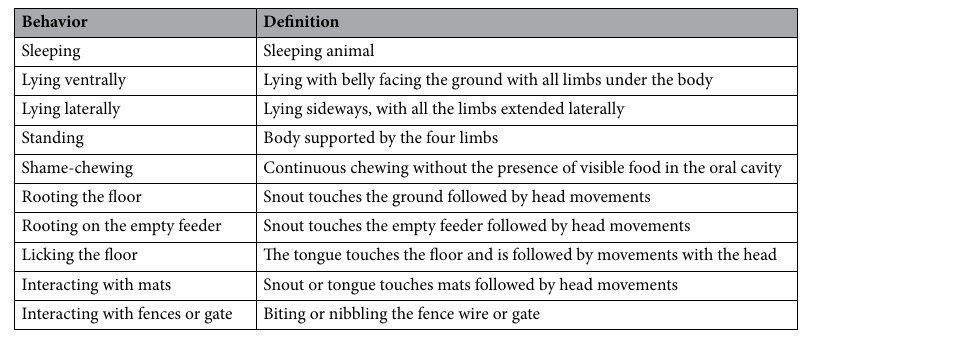
Table 2. Sows behaviors collected on first, second and last third of gestation, before and after feeding. . Adapted from Ref. 31 .